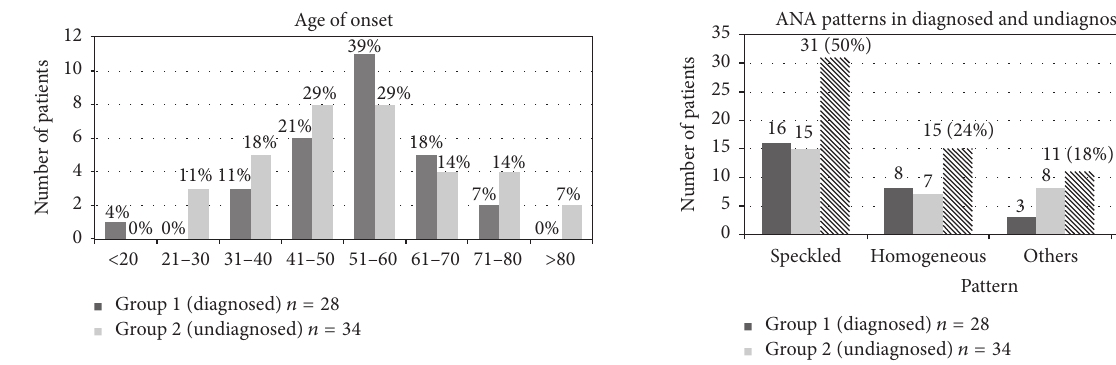
Figure3:Distributionofageofonsetindiagnosedandundiagnosed patients.